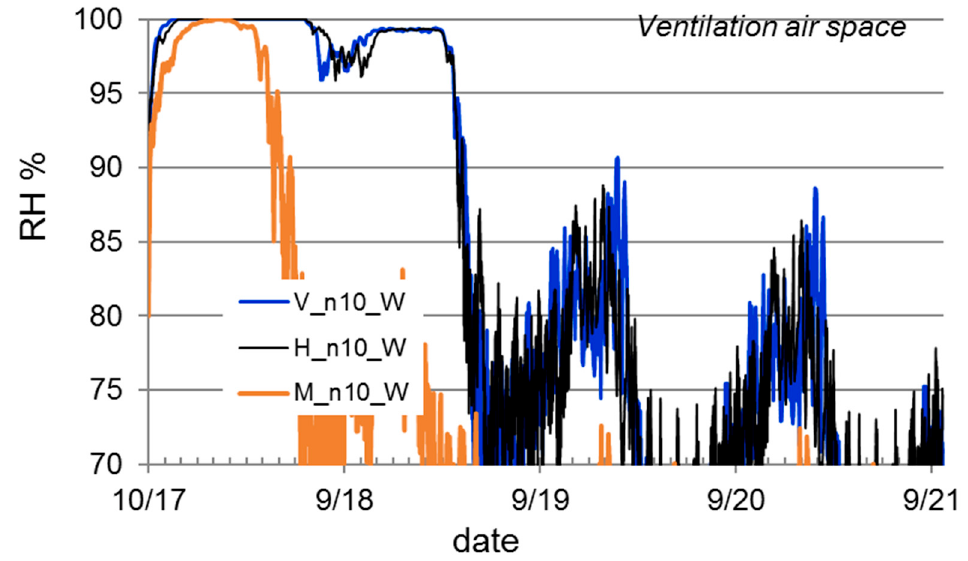
Figure 21. Brick wall, wet exterior core, ventilation scheme 2, n = 10 1/h. The relative humidity in the ventilation air space in the boundary between mineral wool back layer insulation and the PU-insulation of the panel in three different climates during the four-year simulation period.